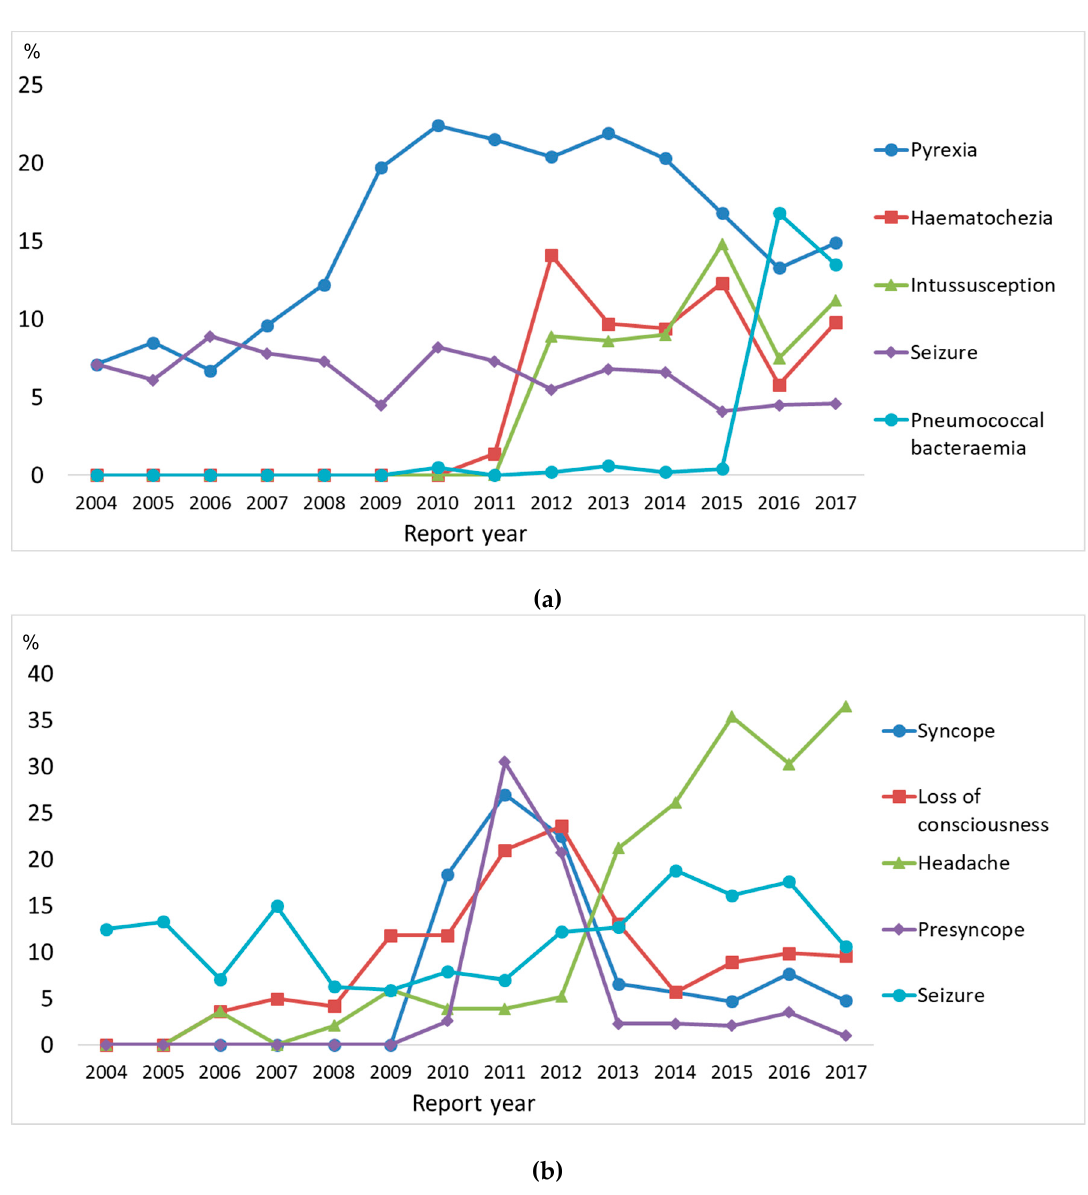
Figure 3. Time trend of five most frequently reported adverse reactions according to age group. ( a ) Children <10 years old. ( b ) Children 10–19 years old.